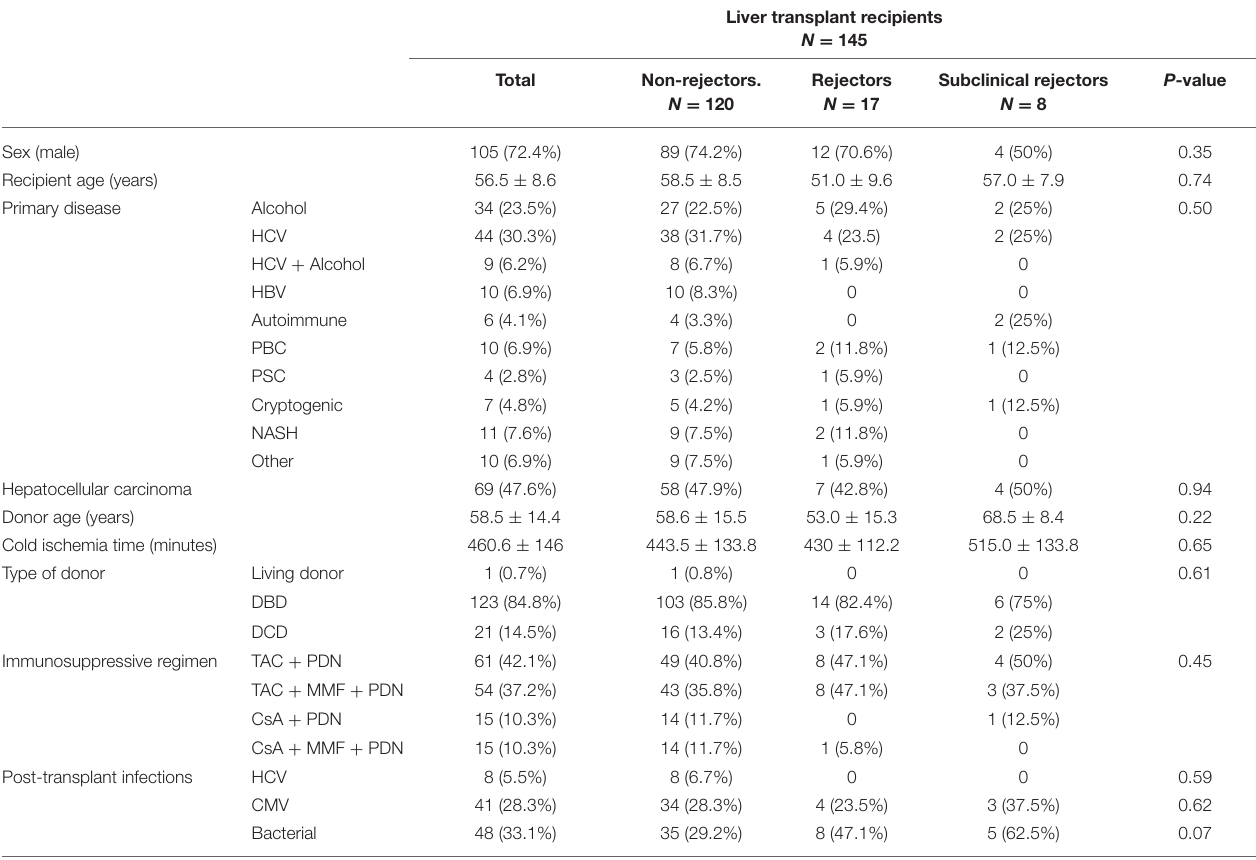
TABLE 1 | Characteristics of 145 liver transplant